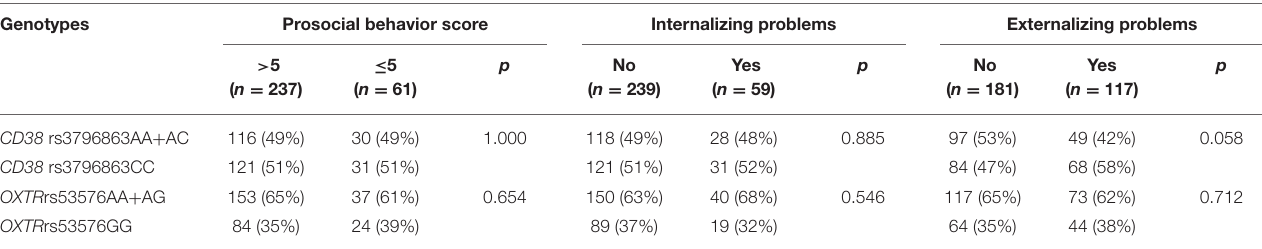
TABLE 2 | The CD38 rs3796863 and OXTR rs53576 genotypes distributions according to SDQ results.